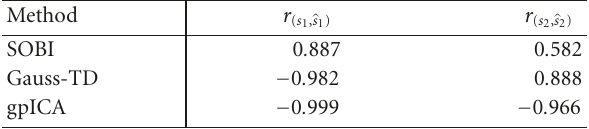
Table 1: Experiment 1: mixture of two sinusoidal signals— correlation coe ffi cient between the original sources and their esti- mates.